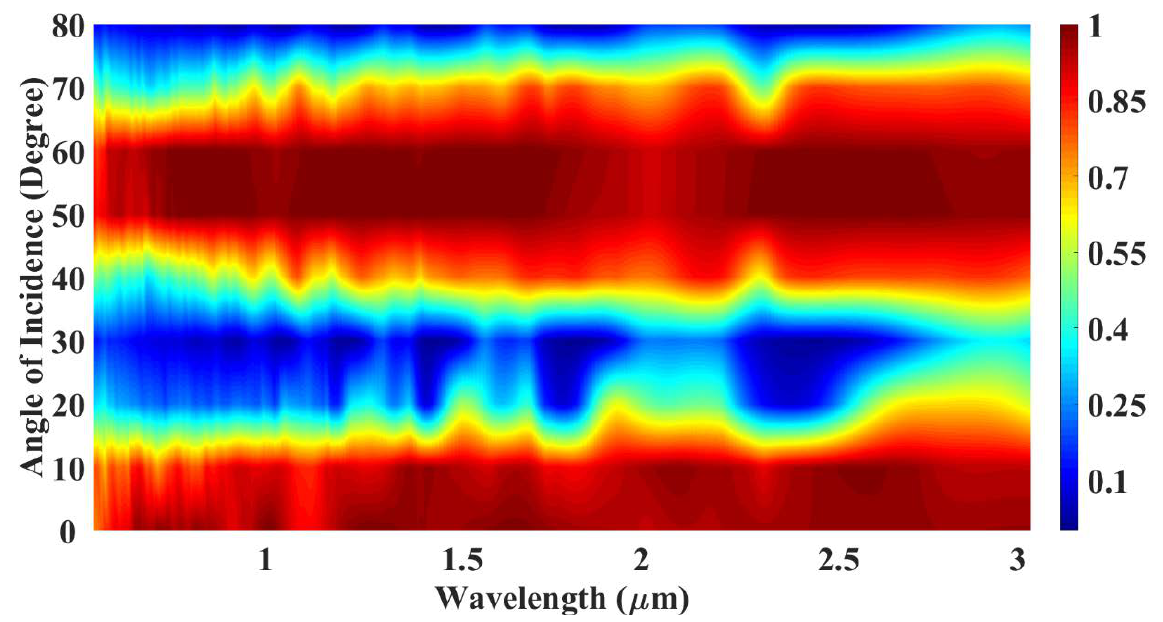
Figure 6. Angle of incidence variation for wavelengths from 500 nm to 3000 nm. For most of the range, absorption is high. The 30° does not have high absorption until 2500 nm, after which absorption improves until 3000 nm. The absorption level is good for most of the angles. The 30° angle exhibits 30–50% absorption. Table 1. Comparison of solar absorber designs with the proposed double substrate design of I-shape metamaterial and thin metamaterial.